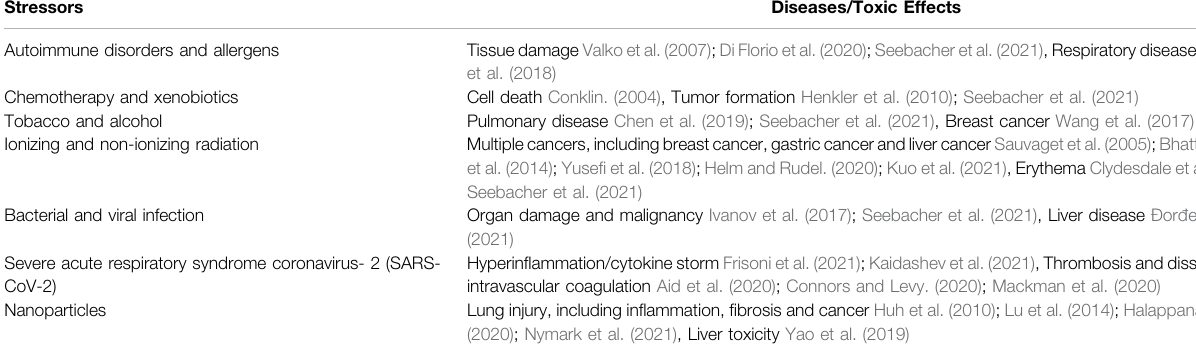
TABLE 1 | Stressors and diseases related to reactive oxygen species and oxidative stress.